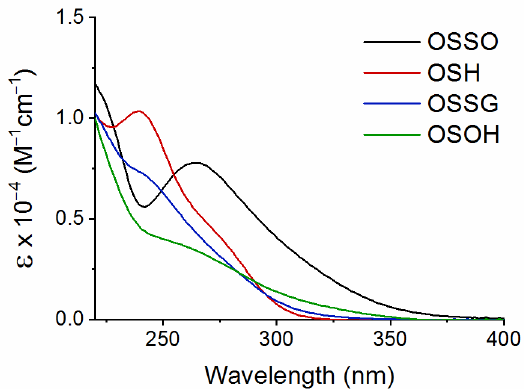
Figure 1. Optical absorption spectra of OSH, OSSO, OSSG and OSOH.